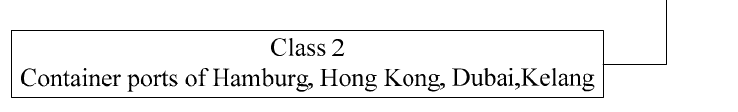
Figure 3. The three classes of the 10 container ports along the MSR.